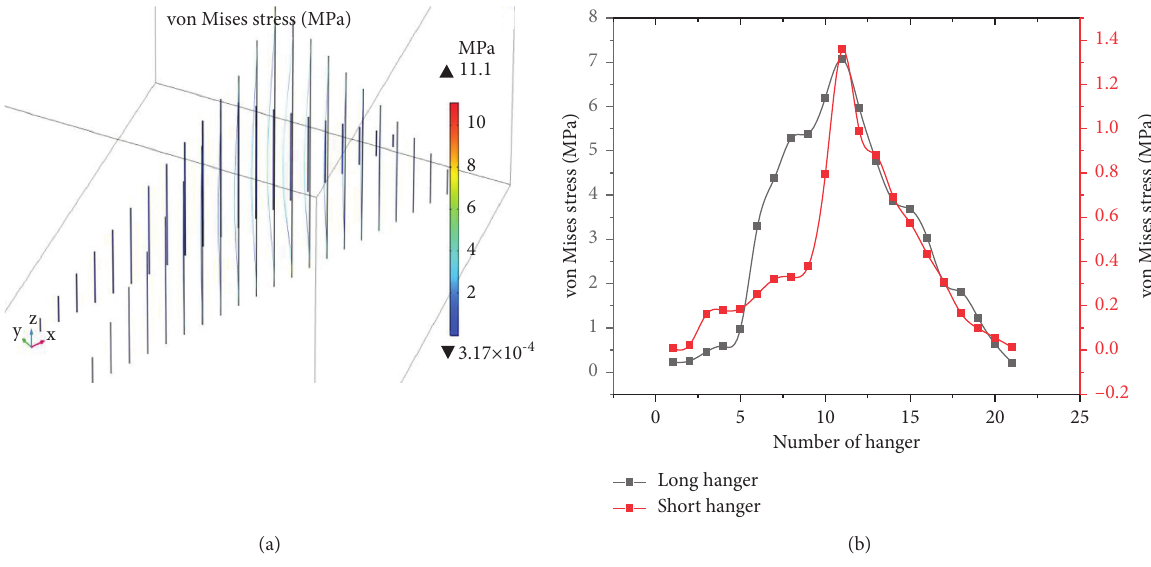
Figure 14: Stress distribution of hangers (wind direction � 240 ° /300 ° ).